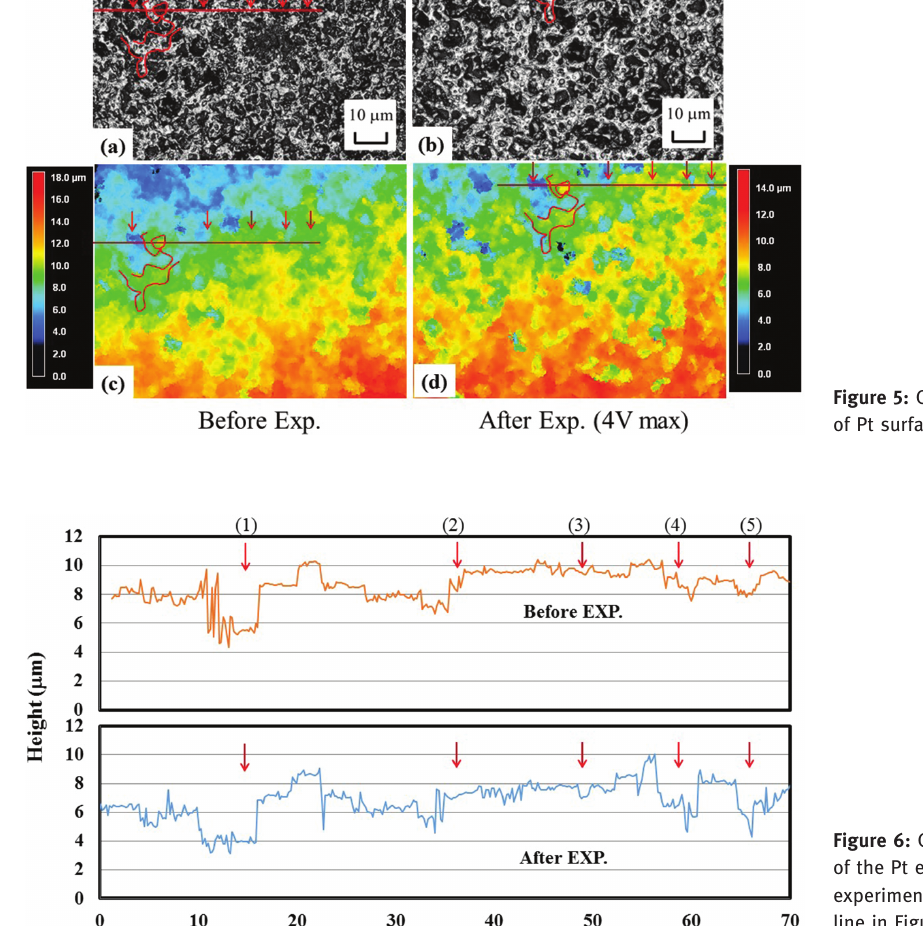
Figure 6: Comparison of the surface profiles of the Pt electrode before and after experiment. The position is indicated by the line in Figure 5 (five small arrows means the positions of holes).